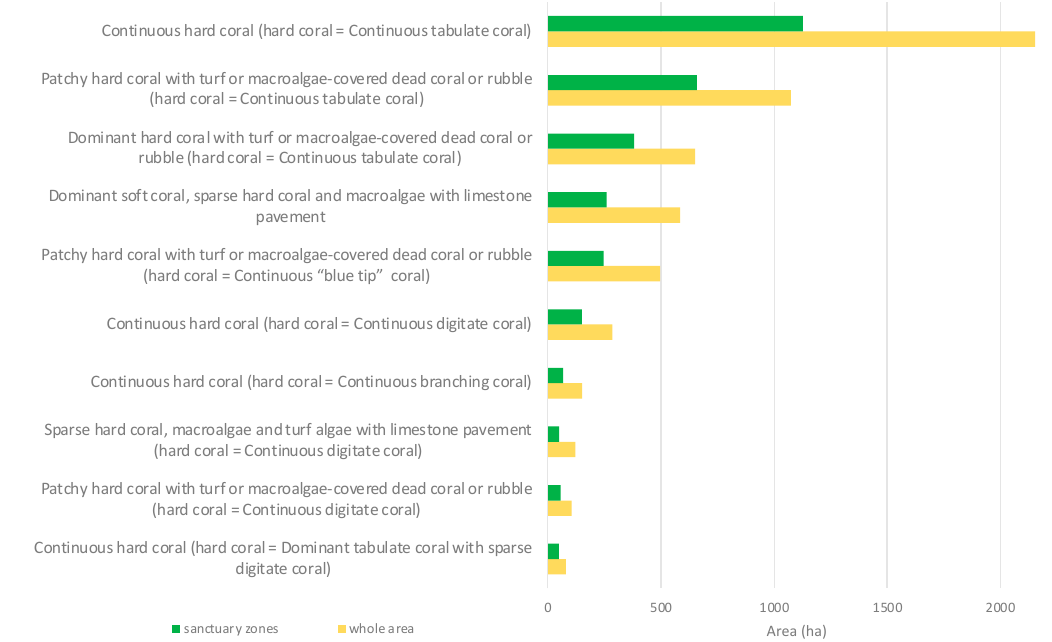
Figure 3. Summary of coral mosaics within the Ningaloo Reef study area (<20 m depth) and in sanc- tuary zones. Data are sorted by the area covered from largest to smallest for the top 10 classes, ac- counting for 97% of the total coral cover.